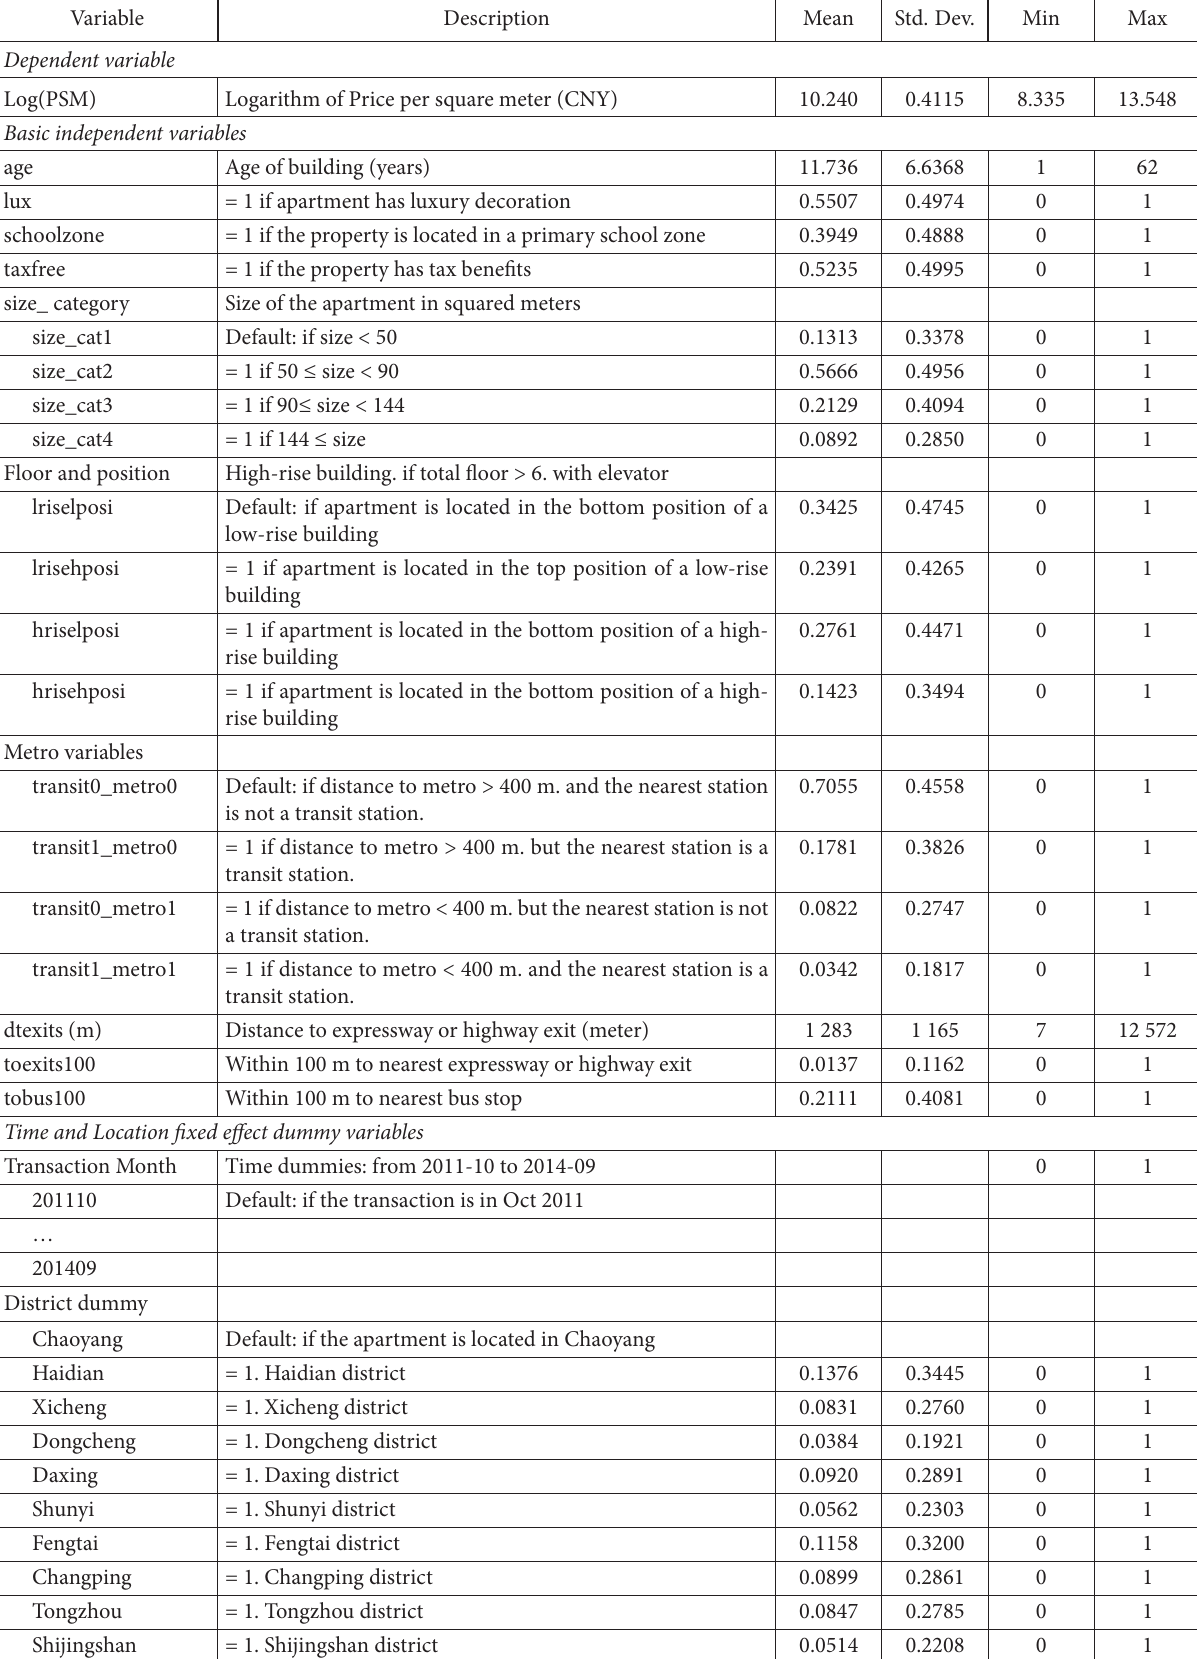
Table 1. Description of data on Beijing residential markets. The number of observations is 63 306 for the entire study area